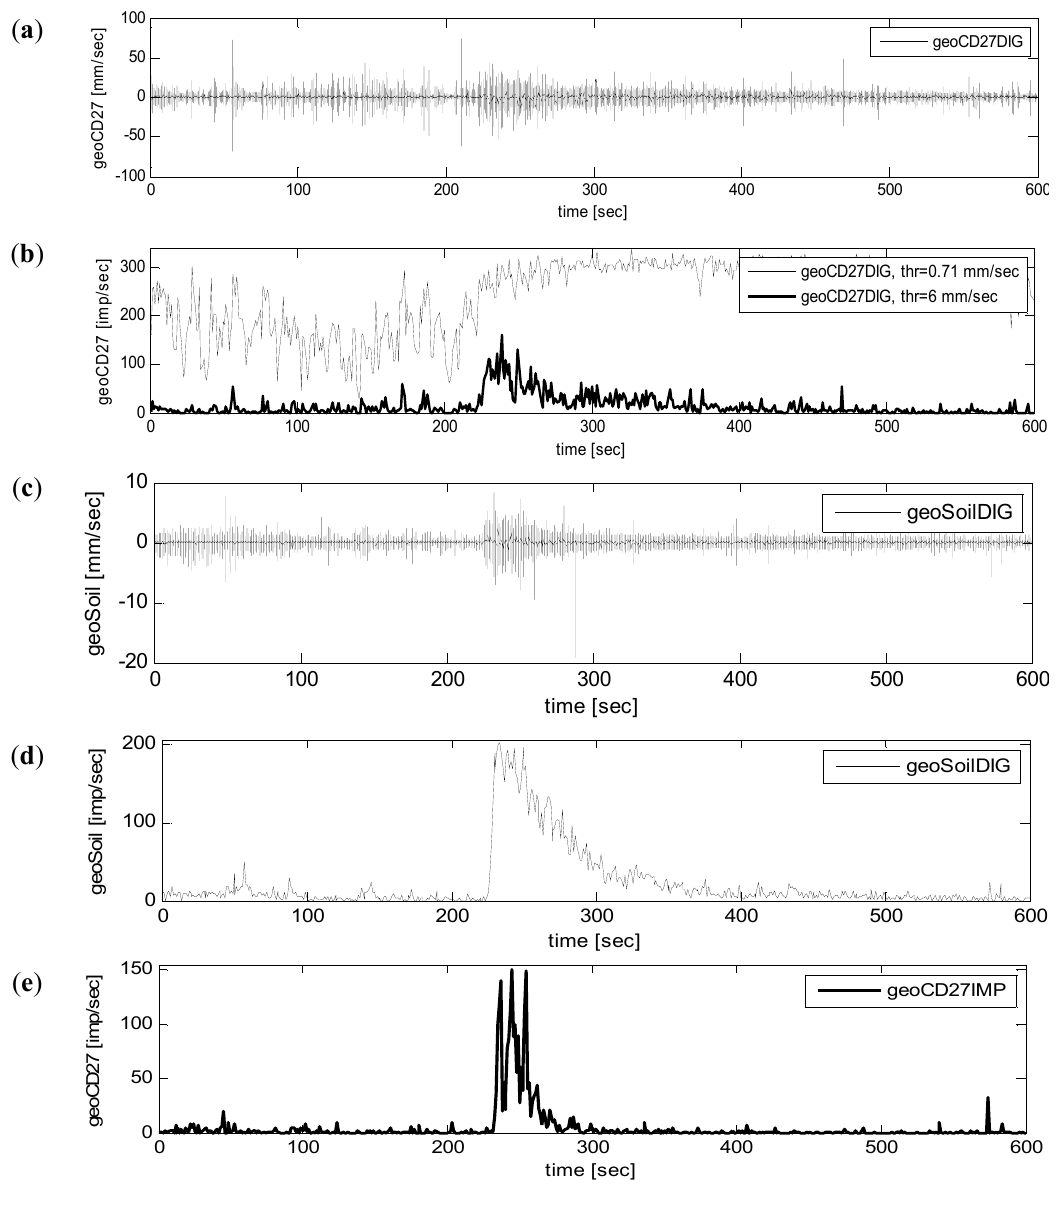
Figure 8. Data recorded in Illgraben during the event occurred in 27 July 2009. ( a ) Ground velocity signal (GVS) measured by geoCD27DIG (sample rate: 2 kHz) ( b ) Impulse per second (IS) time series obtained by post-processing geoCD27DIG data using the